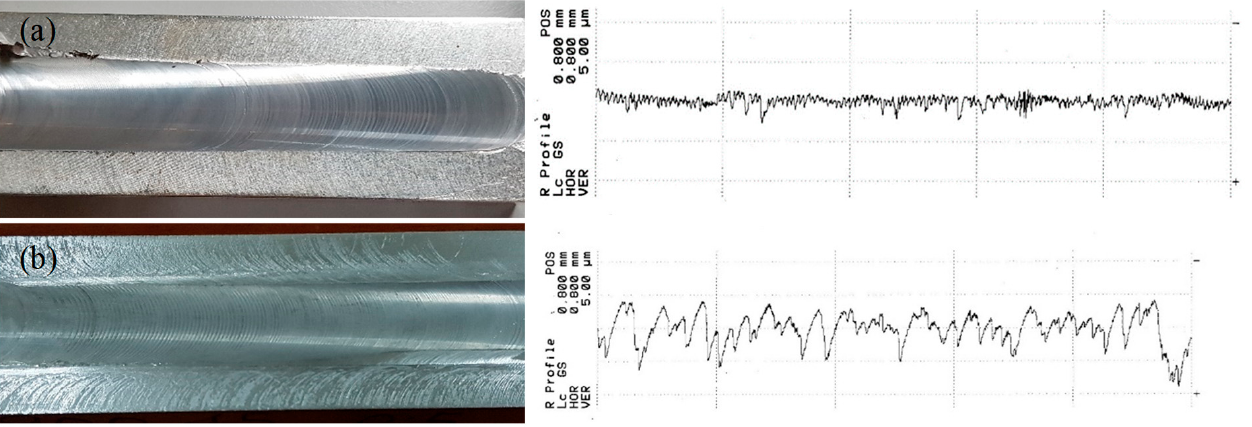
Figure 10. FSPed surface roughness, ( a ) average R a , ( b ) R q , ( c ) R sk , and ( d ) R ku values.